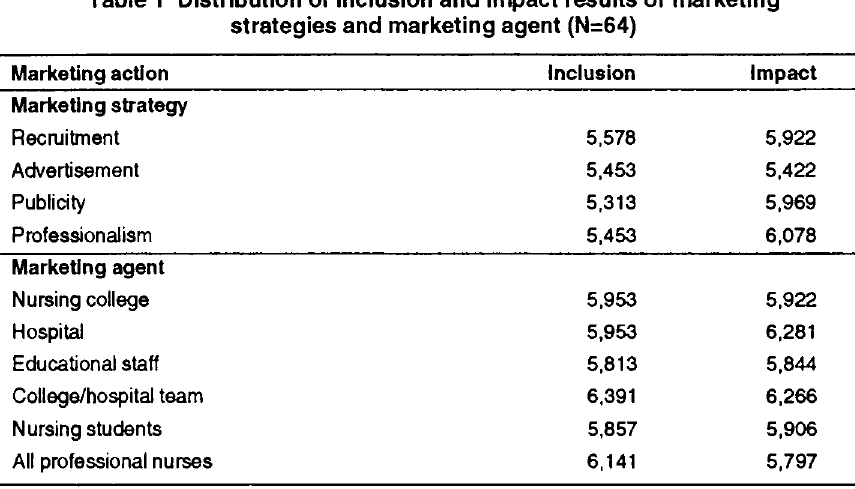
Table 1 Distribution of inclusion and impact results of